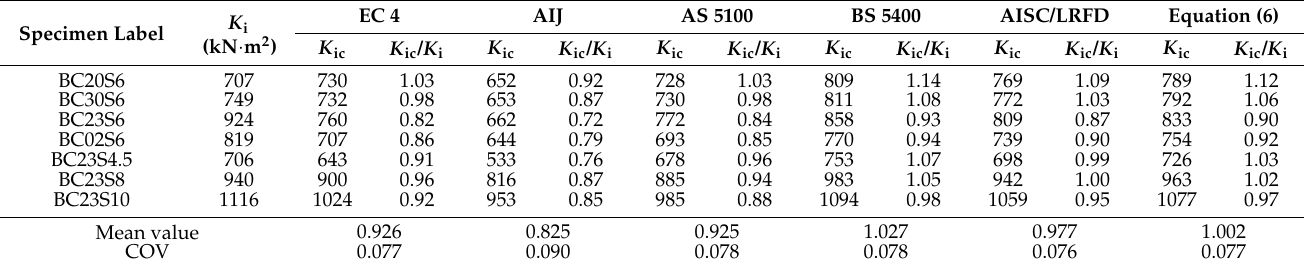
Figure 14. Comparisons of flexural stiffness. ( a ) Initial section flexural stiffness; ( b ) serviceability-level section flexural stiffness. Table 7. Comparisons of the measured initial flexural stiffness with the predictions of the design guidelines.